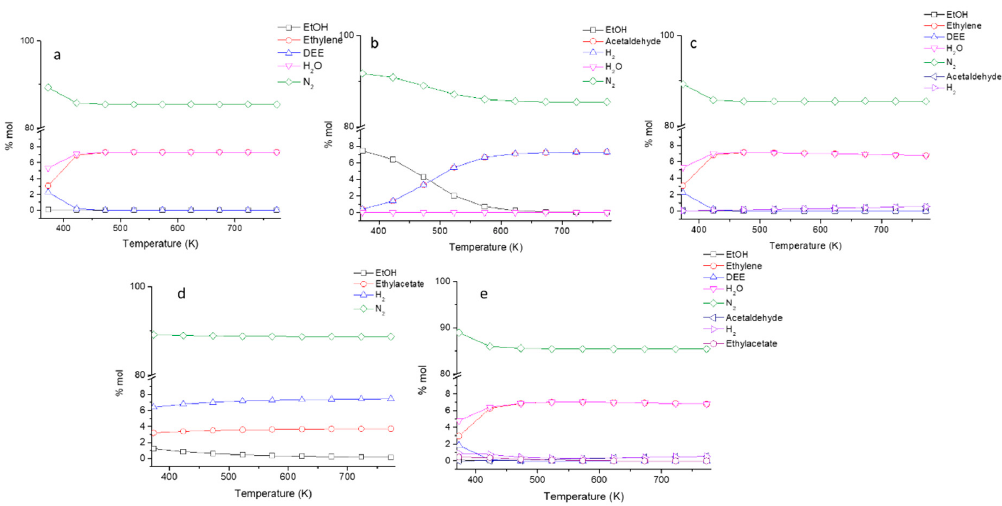
Figure 2. Evaluated thermodynamic equilibrium in terms of molar fractions for the different investigated mixtures with the same reaction condition employed in the catalytic experiments; ( a ) N 2 /ethanol/water/DEE/ethylene, ( b ) N 2 /ethanol/acetaldehyde/H 2 , ( c ) N 2 /ethanol/water/DEE/ethylene /acetaldehyde/H 2 , ( d ) N 2 /ethanol/ethyl acetate/H 2, and ( e ) N 2 /ethanol/water/DEE/ethylene/ acetaldehyde / H 2 /ethyl acetate.